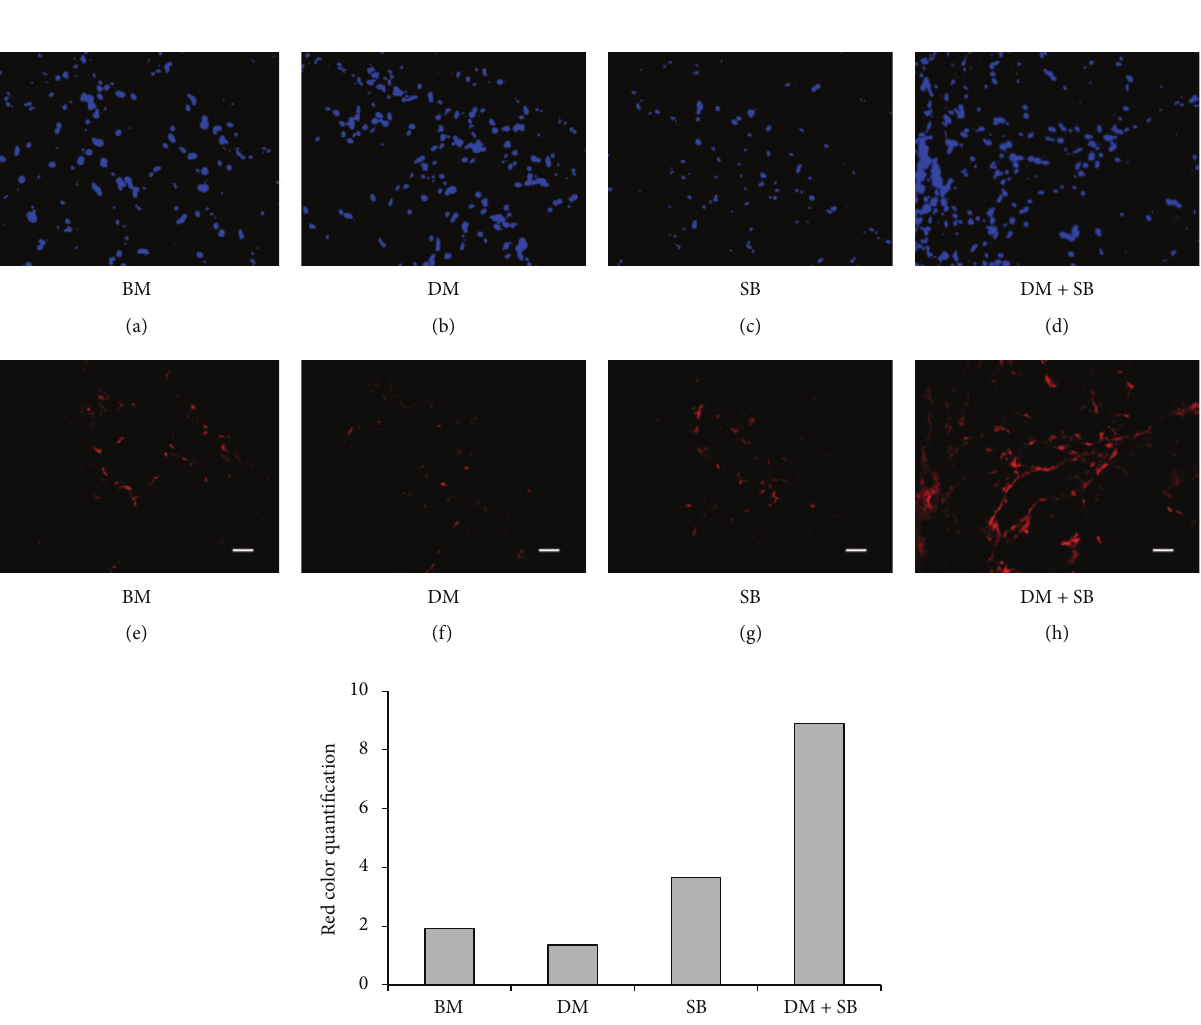
Figure 7: hADSCs activated with SB and DM for 7 days induce significant axonal outgrowth formation upon their transplantation in vivo . hADSCs were grown in BM or BM supplemented with either activin/nodal/TGF- 𝛽 pathway inhibitor SB or BMP pathway inhibitor DM or both for 7 days. The cells were harvested after 7 days and 0.5 × 10 6 cells were mixed with 200 𝜇 L of Matrigel and implanted subcutaneously in C.B-17 SCID mice. Implants were harvested after 14 days and the cryosections were stained with DAPI ((a)–(d)) or with anti-GAP43 antibody followed by Alexa Fluor 596 conjugated secondary antibody ((e)–(h)). The slides were observed under a fluorescent microscope. Immunohistochemistry of hADSCs implants revealed that expression of axon growth cone specific GAP43 protein residing in the nerve fibers was maximum in implants of hADSCs treated with SB and DM. Scale bar = 100 𝜇